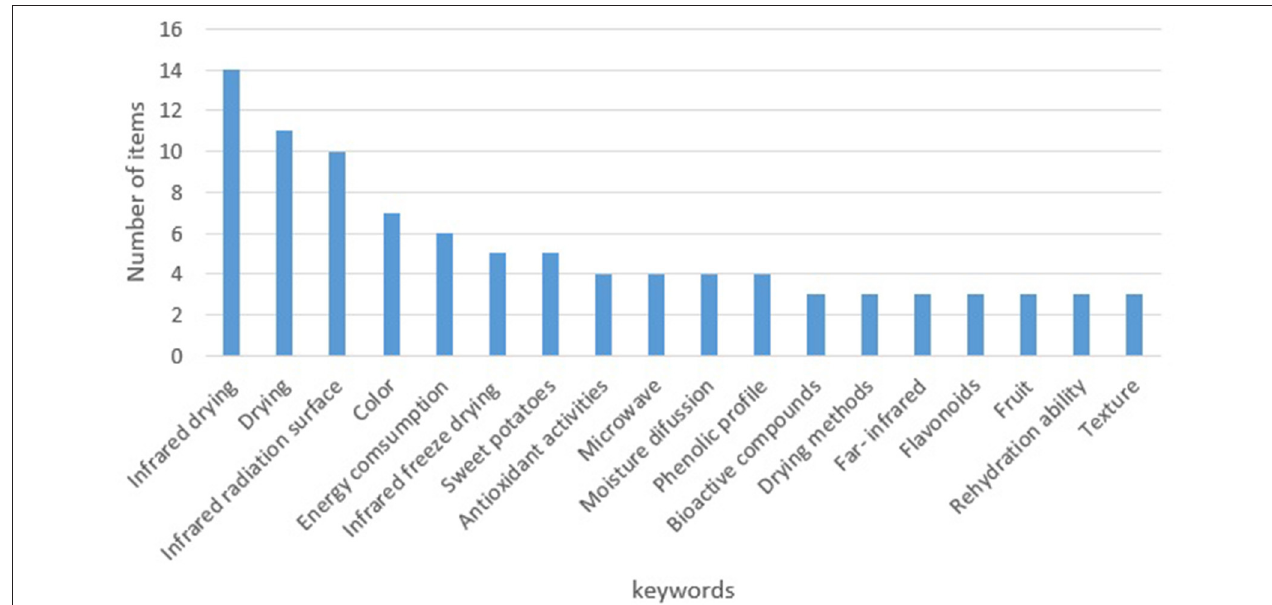
FIGURE 5 | Word most found keys. Source: the authors.